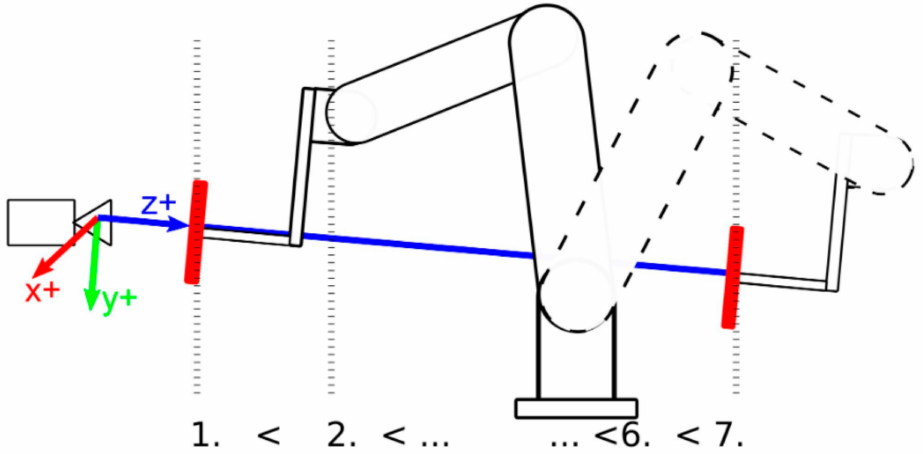
Figure 3. Scheme for general accuracy and precision measurements using robotic